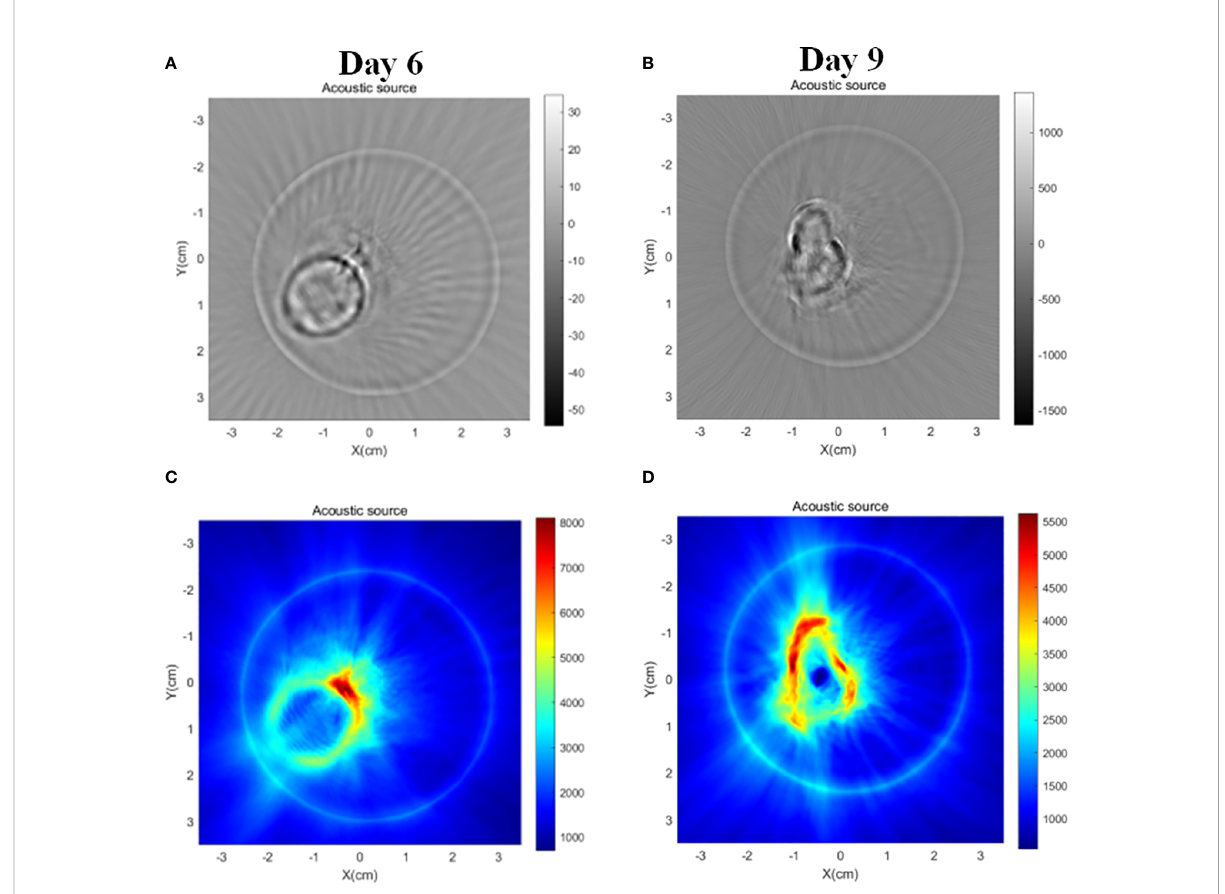
FIGURE 11 MAT images of tumor-bearing mice in LM group on day 6 and day 9, respectively. (A) MAT images of tumor mice on day 6 (B) MAT images of tumor mice on day 9. (C) Magneto-acoustic signal intensity distribution images of tumor mice on day 6, and (D) magneto-acoustic signal intensity distribution images of tumor mice on day 9. The red area in the image represents the LM distribution